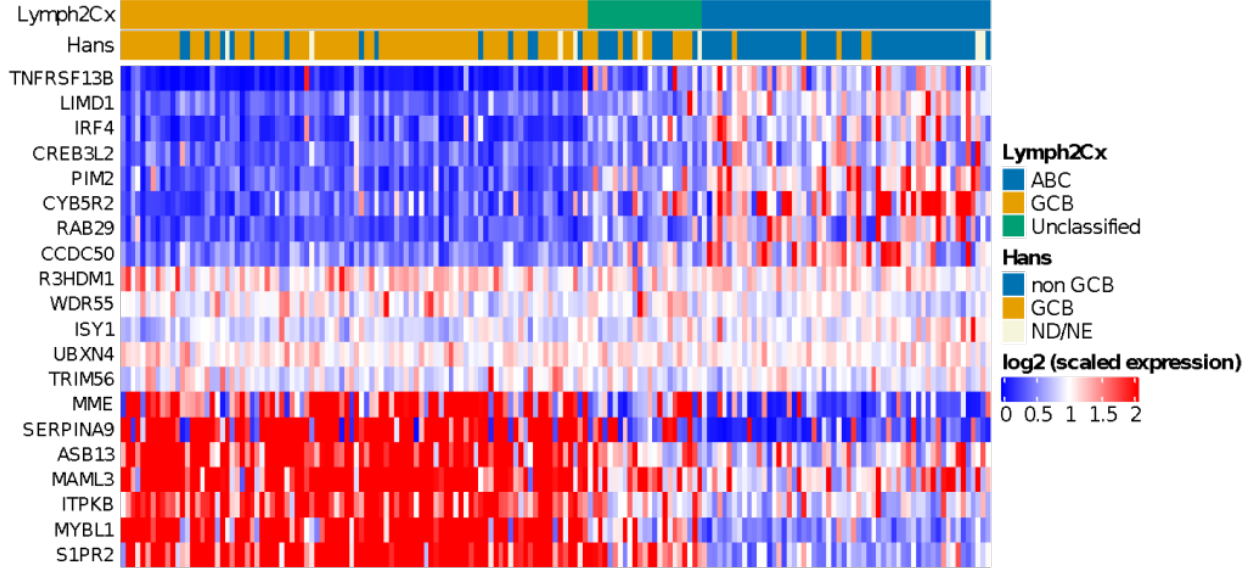
Figure 1. Heatmap showing relative expression levels of the COO genes used to classify cases using the Lymph2Cx algorithm. A clearly distinct gene expression pattern can be observed for ABC and GCB subtype DLBCL cases.